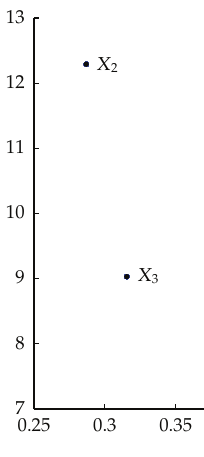
Figure 6: A stable 4-cycle near an R4 point for a (cid:8) 4 . 99, b (cid:8) 0 . 2, and d (cid:8) 2 . 56.